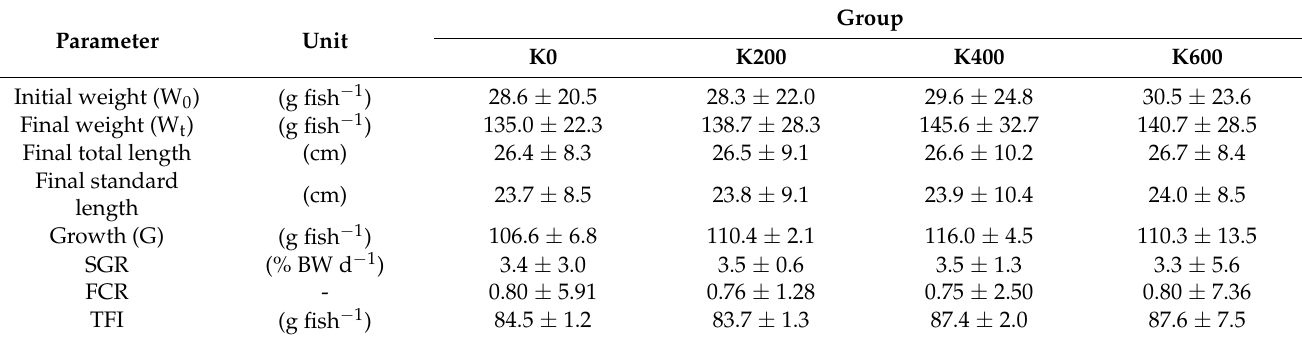
Table 2. Fish growth and feed efficiency of C. gariepinus (mean ± CV). Final sampling was performed on day 42.